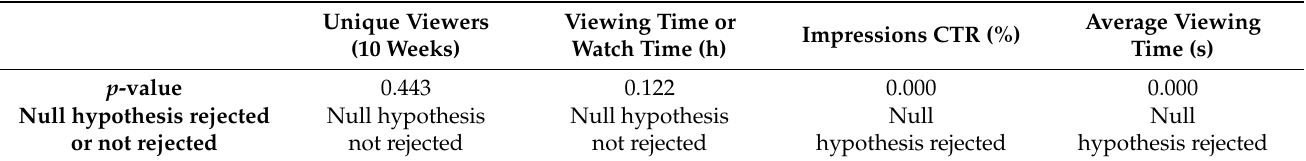
Table 6. Mann–Whitney–Wilcoxon test results for the four variables “Unique viewers”; “Watch time”; “Impressions CTR”; and “Average viewing